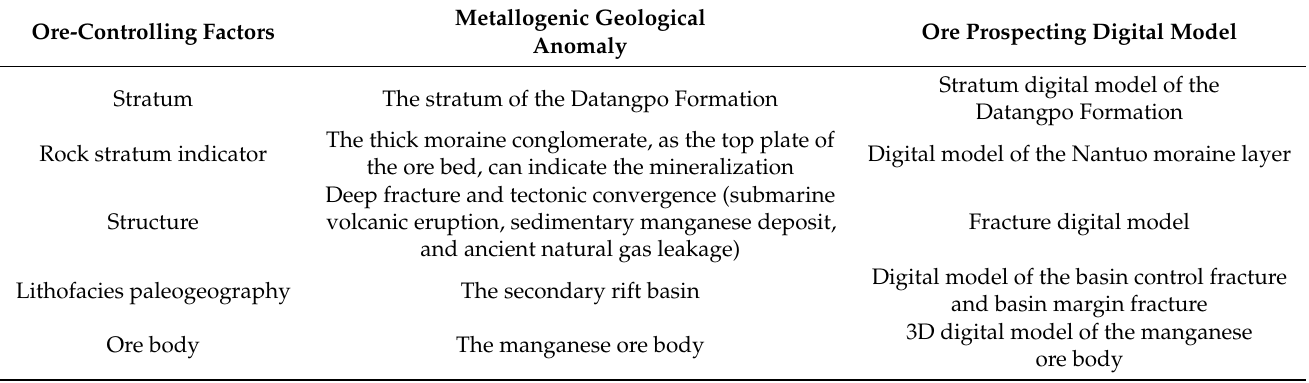
Table 5. The prospective ore model for the Minle mining area.